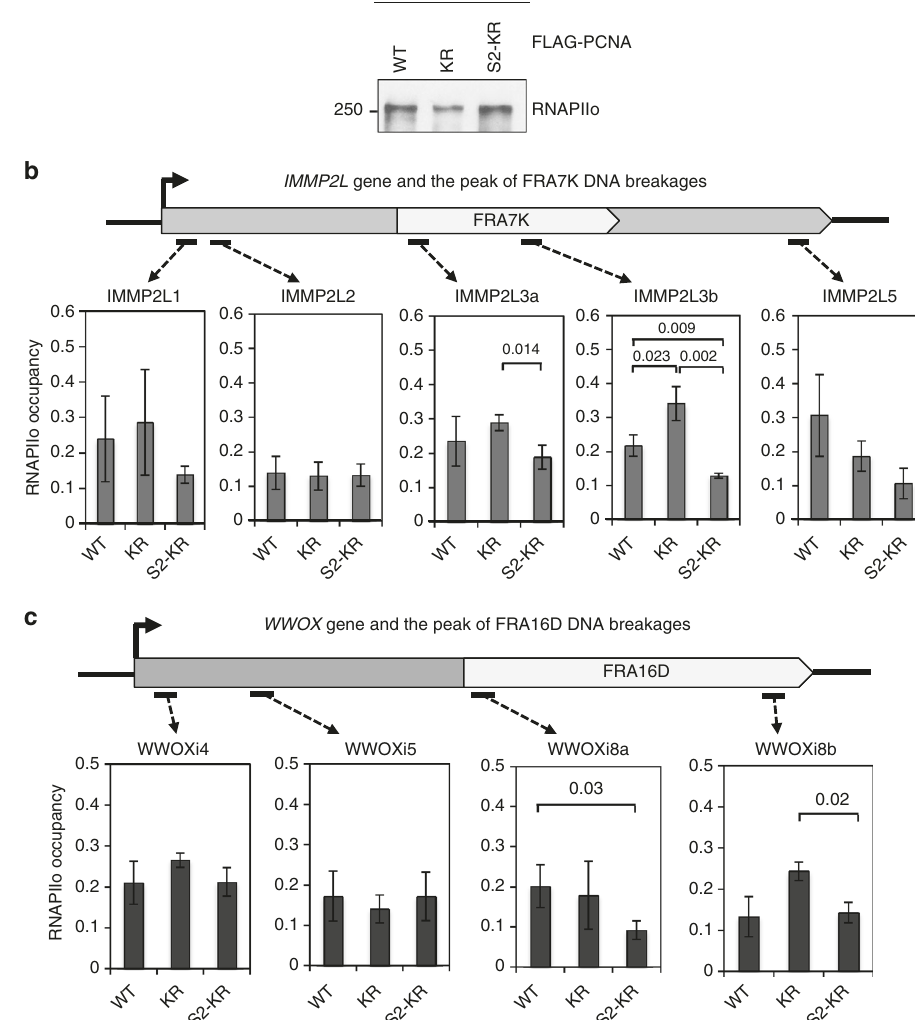
Fig. 3 SUMO2-PCNA reduces RNAPII occupancy on chromatin. a Western blot analysis of immunopuri fi ed RNAPIIo using an α -RNAPII phosphor-CTD 4H8 antibody from formaldehyde-treated HEK293T cells overexpressing FLAG-PCNA WT, KR, or S2-KR fusion proteins. The blot was probed using an α - RNAPII A10 antibody. b , c (top) Schematic diagrams of regions containing DNA breaks associated with the FRA7K and FRA16D CFSs (light gray) in IMMP2L ( b ) and WWOX ( c ), respectively 28,29 . (bottom) ChIP analysis of RNAPIIo occupancy at the indicated regions of the IMMP2L ( b ) and WWOX ( c ) genes using primers derived from Helmrich et al 3 (Supplementary Table 2). Each value represents the average value ± standard deviation calculated from triplicate qPCR reactions per one representative experiment. p values were calculated using t -test analysis for statistically signi fi cant differences. Only p values equal to or less than 0.05 are shown. The result was reproduced in three independent